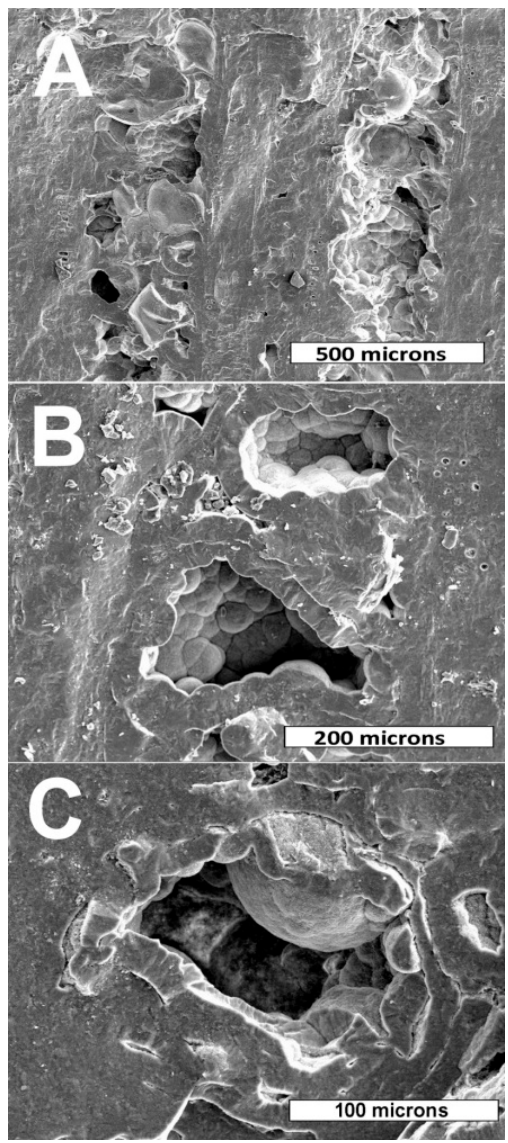
Figure 10. SEM SE images showing vessels partially filled with chalcedony. ( A ) Tangential view of two vessels surrounded by vitreous opal; ( B ) tangential view, fibrous chalcedony forming walls in the vessel and semi-spherical masses (botryoidal texture); ( C ) transverse view of a chalcedony-mineralized vessel. The coloration of the fossil wood may be at least in part the result of trace amounts of iron.